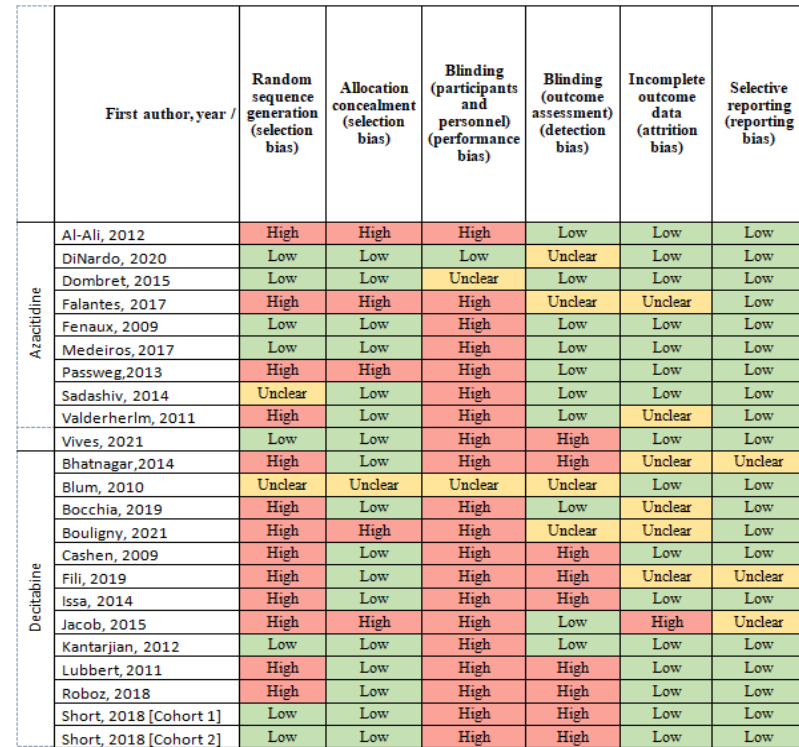
Figure 6. Risk of